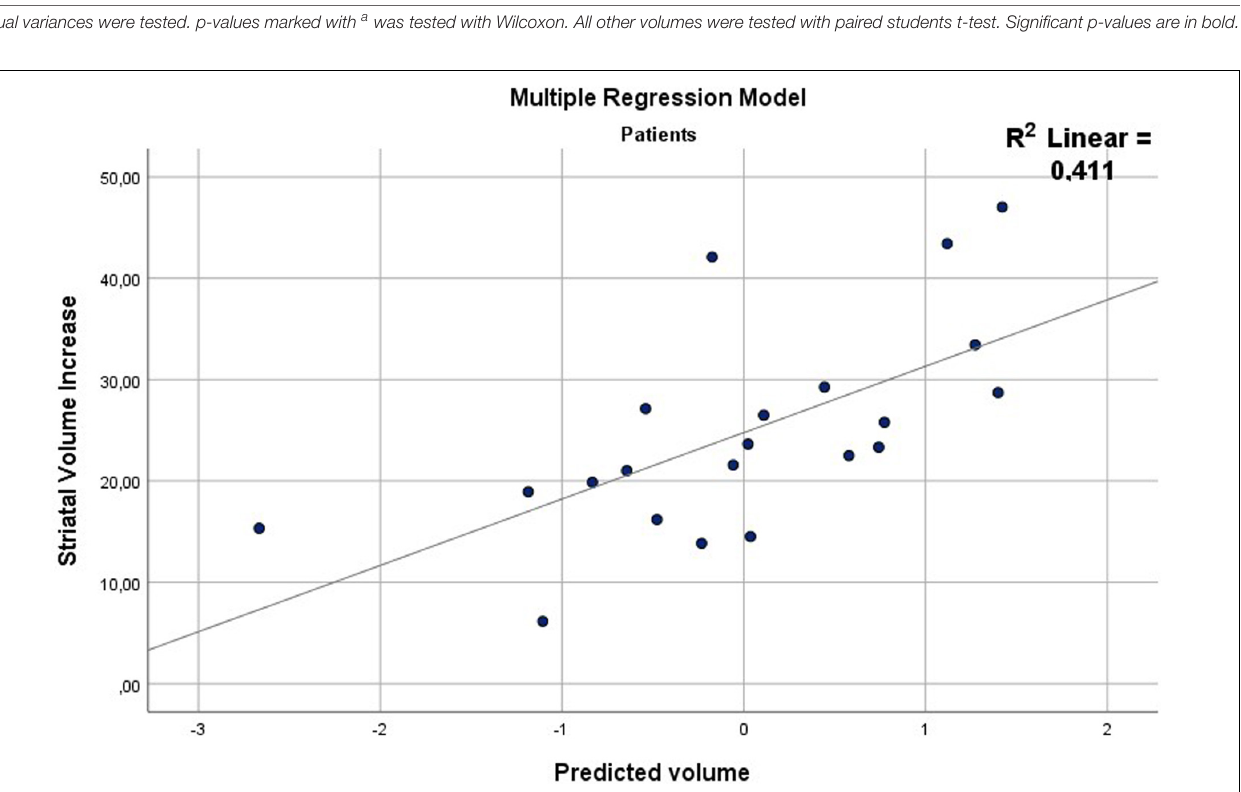
FIGURE 2 | Scatter plot of the multiple regression model including dose, striatal receptor occupancy and PANSS positive score as predictive/independent variables. The dependent variable, striatal volume increase, is depicted on the y-axis, the independent variables on the x-axis. The model significantly predicted striatal volume increase ( r 2 = 0.411, p = 0.026). Only dose was a unique predictor of volume increase when controlling for the other variables ( r 2 = 0.553, p = 0.028). All model coefficients can be seen in Supplementary Table S1